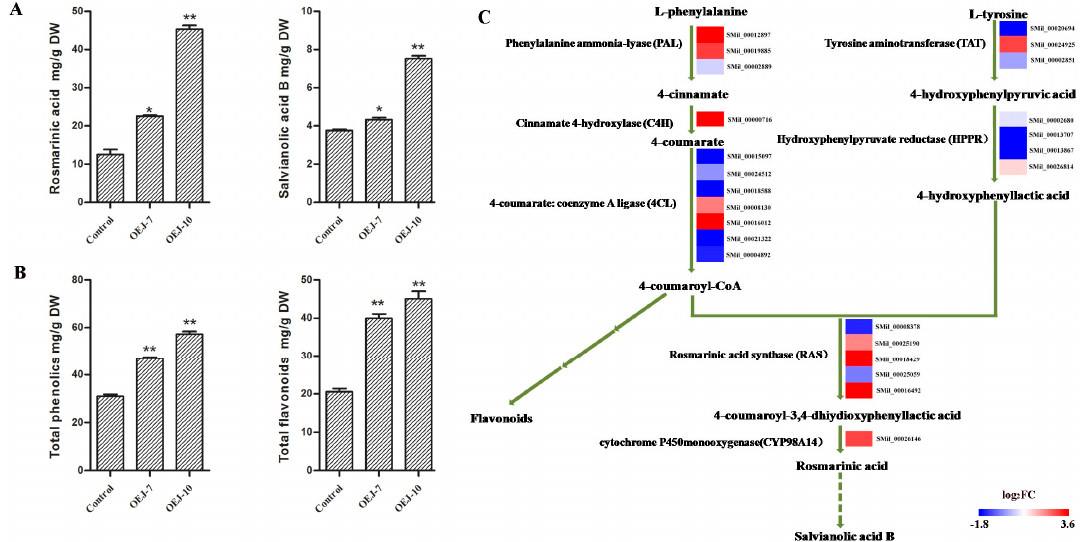
Figure 3. ( A ) Concentrations of rosmarinic acid (RA) and salvianolic acid (Sal B) in root extracts from control and transgenic OEJ-7 and OEJ-10 plants. All data are means of three replicates, with error bars indicating SD. ** Values are significantly different from the control at p < 0.01. ( B ) Concentrations of total phenolics and total flavonoids in root extracts from control and transgenic OEJ-7 and OEJ-10 plants. All data are means of three replicates, with error bars indicating SD. * and ** Values are significantly different from the control at p < 0.05 and p < 0.01, respectively. ( C ) Differentially expressed genes (DEGs) involved in the pathway for salvianolic acid biosynthesis between OEJ-10 and the control. For each gene, relative expression (OEJ-10 versus control) is represented as log 2 FC. The color scale is shown at the bottom. Higher expression levels are shown in red.